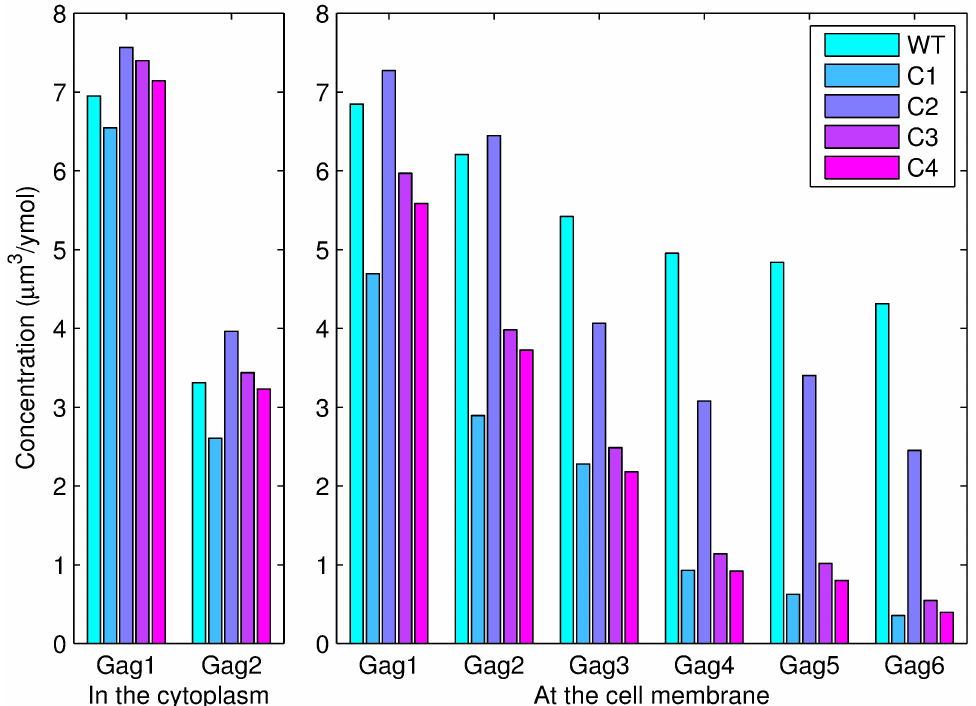
Fig 13. Concentration of polymers in the cytoplasm and PM during the first 30 minutes of simulations using the four theoretical combined methods and WT Gag. Gagi ( i = 1, 2, (cid:1)(cid:1)(cid:1) , 6) denotesa polymerwith i